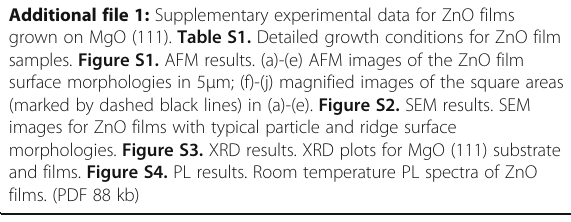
samples. Figure S1. AFM results. (a)-(e) AFM images of the ZnO film surface morphologies in 5 μ m; (f)-(j) magnified images of the square areas (marked by dashed black lines) in (a)-(e). Figure S2. SEM results. SEM images for ZnO films with typical particle and ridge surface morphologies. Figure S3. XRD results. XRD plots for MgO (111) substrate and films. Figure S4. PL results. Room temperature PL spectra of ZnO films. (PDF 88